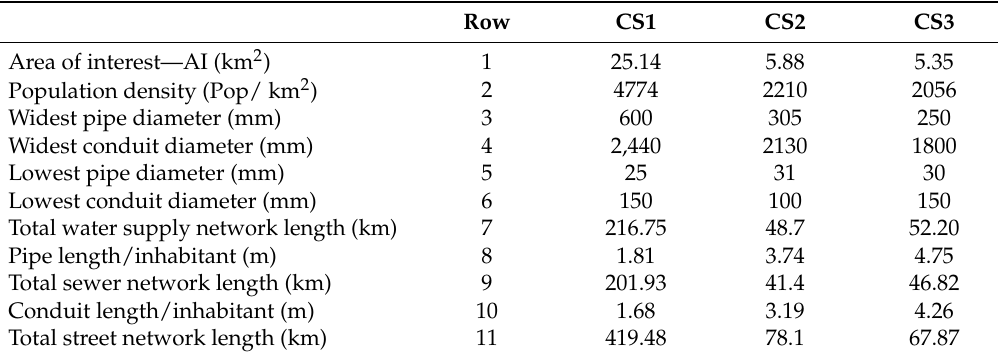
Table 2. Area of interest properties for all case